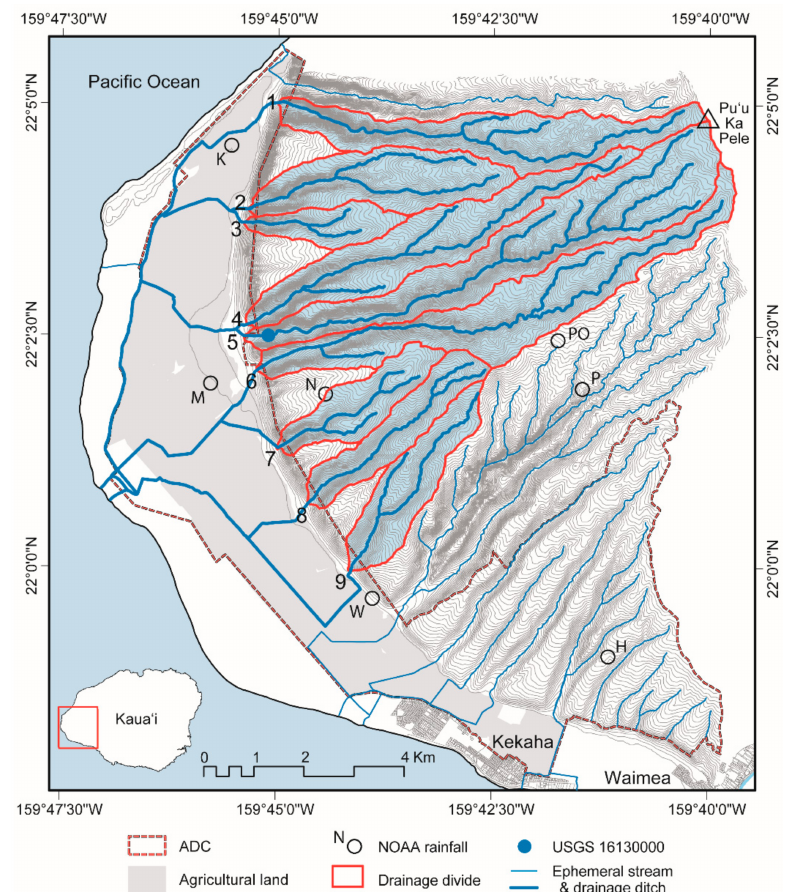
Figure 3. Storm runoff flowpaths to Kinikini and Dry Ditch (heavy blue lines) and other drainage ditch system outlets (light blue lines), and HEC-HMS basins and stream networks (see Table 1 for basin names, 1–9). Contour interval 10 m (cf. Figure 1). The locations of the USGS gauging station on Nahomalu Steam (USGS 16,130,000), and the NOAA atlas rainfall stations on Pu‘u Ka Pele Slope and the M¯an¯a Plain from which point precipitation frequency estimates were derived are also shown: H, Hukipo; N, Nui Ridge; P, Puehu Ridge; PO, Pu‘u ‘ ¯Opae; K, Kolo; M, M¯an¯a; W, Waiawa. The boundary of the State of Hawai‘i Agribusiness Development Corporation’s (ADC) land facilitates comparison with Figures 2 and